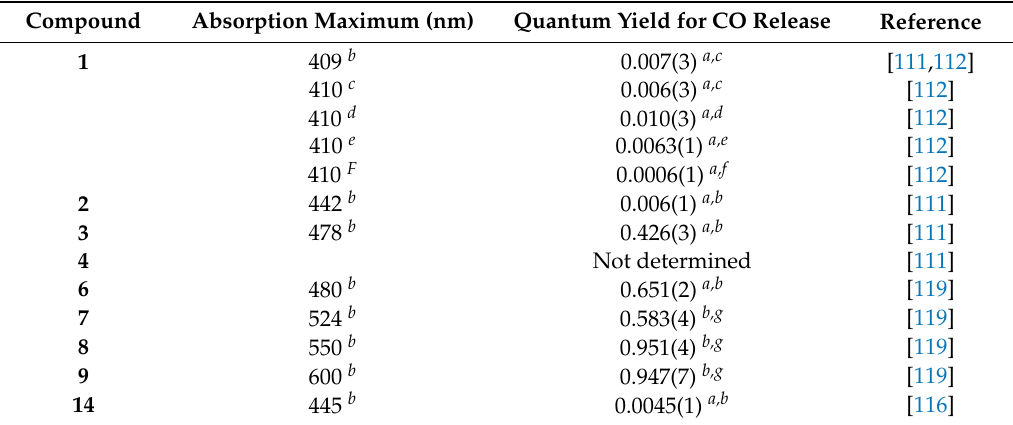
Table 2. Quantum yields for photoinduced CO release from extended 3-hydroxyflavones, zinc flavonolato complexes, and 3-hydroxybenzo[ g